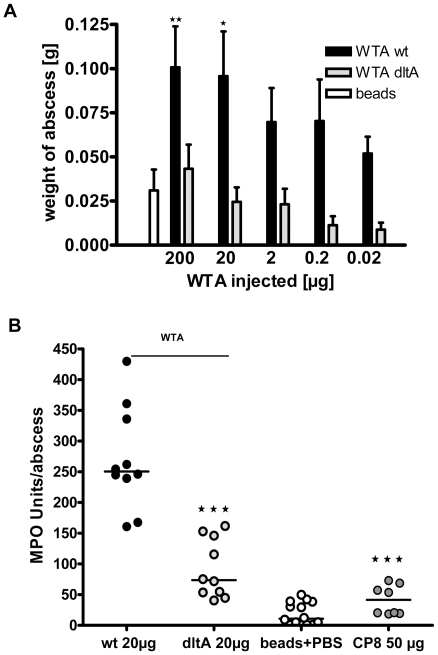
Purified WTA is a potent abscess inducer.WTA was purified from wt SA113 or the dltA mutant, mixed with cytodex beads, and injected s.c. into mouse flanks. A) The weights of the abscesses were determined after 48 h and expressed as mean ± SEM, n = 8. The zwitterionic WTA purified from SA113 induced well-defined abscesses, whereas the negatively charged dltA WTA was only a weak abscess inducer (wt WTA compared to beads p = 0.0062 at 200 µg; p = 0.0381 at 20 µg. dltA WTA compared to beads yielded p values >0.05 at all doses. All p-values were determined by two-tailed Student t-tests). B) 20 µg WTA purified from wild-type SA113 or the dltA mutant was mixed with cytodex beads and injected into the flanks of mice. After 48 h, the abscesses were excised, homogenized, and MPO activity was determined to assess the intensity of the host response. Wt WTA induced strong MPO activity, indicative of neutrophil recruitment, whereas dltA WTA and CP8 were considerably less active (p-values <0.0001 by Mann-Whitney analyses). ★
p<0.05;
★★
p<0.01, ★★★
p<0.001.